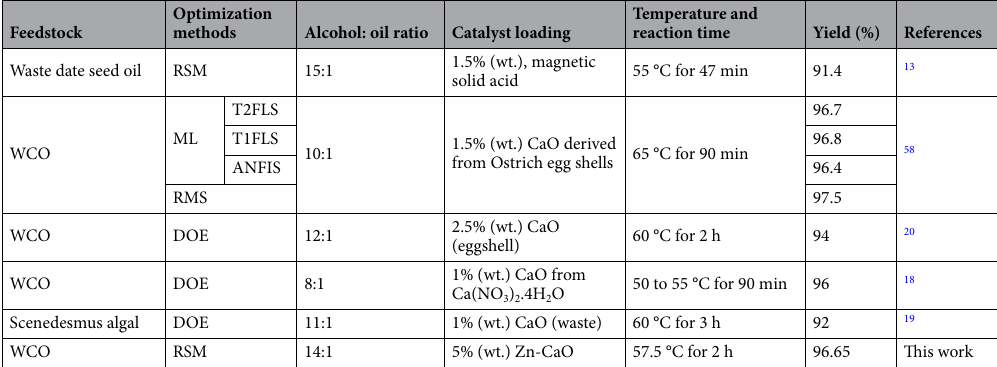
Table 6. A comparison of related works with this work in terms biodiesel yield, optimization technic and optimization parameters.